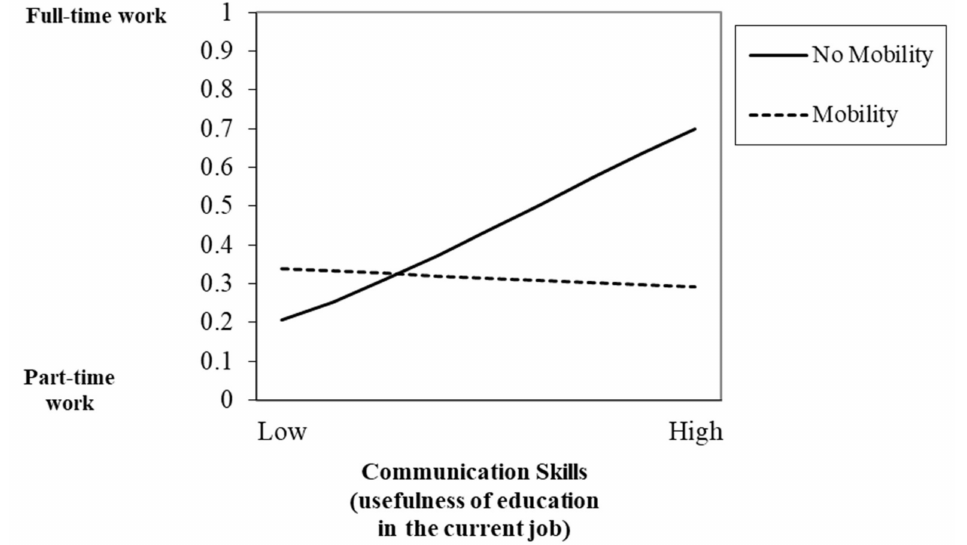
Figure 2. Interaction between communication skills (usefulness of education in the current job) and mobility in predicting full- and part-time work.